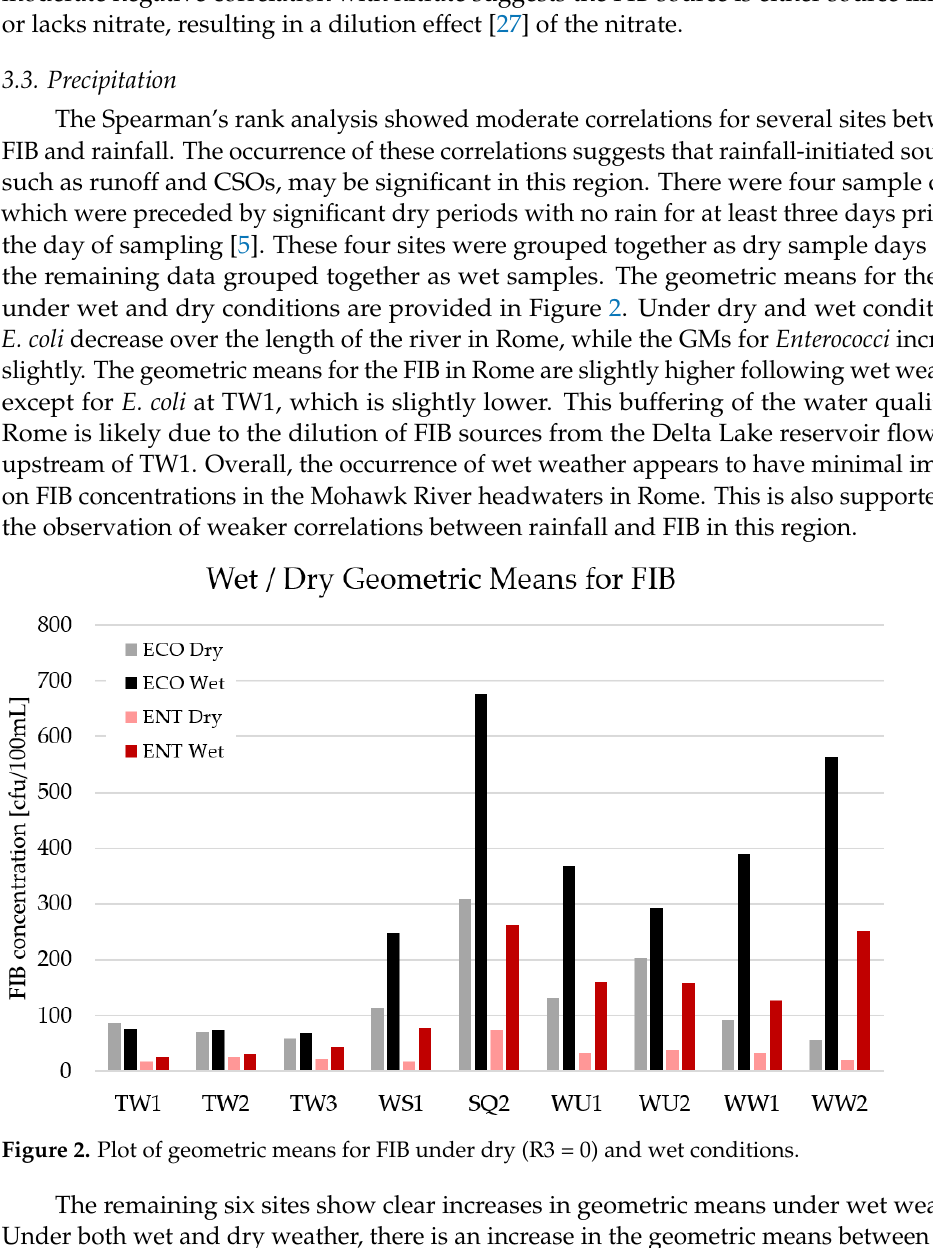
Figure 2. Plot of geometric means for FIB under dry (R3 = 0) and wet